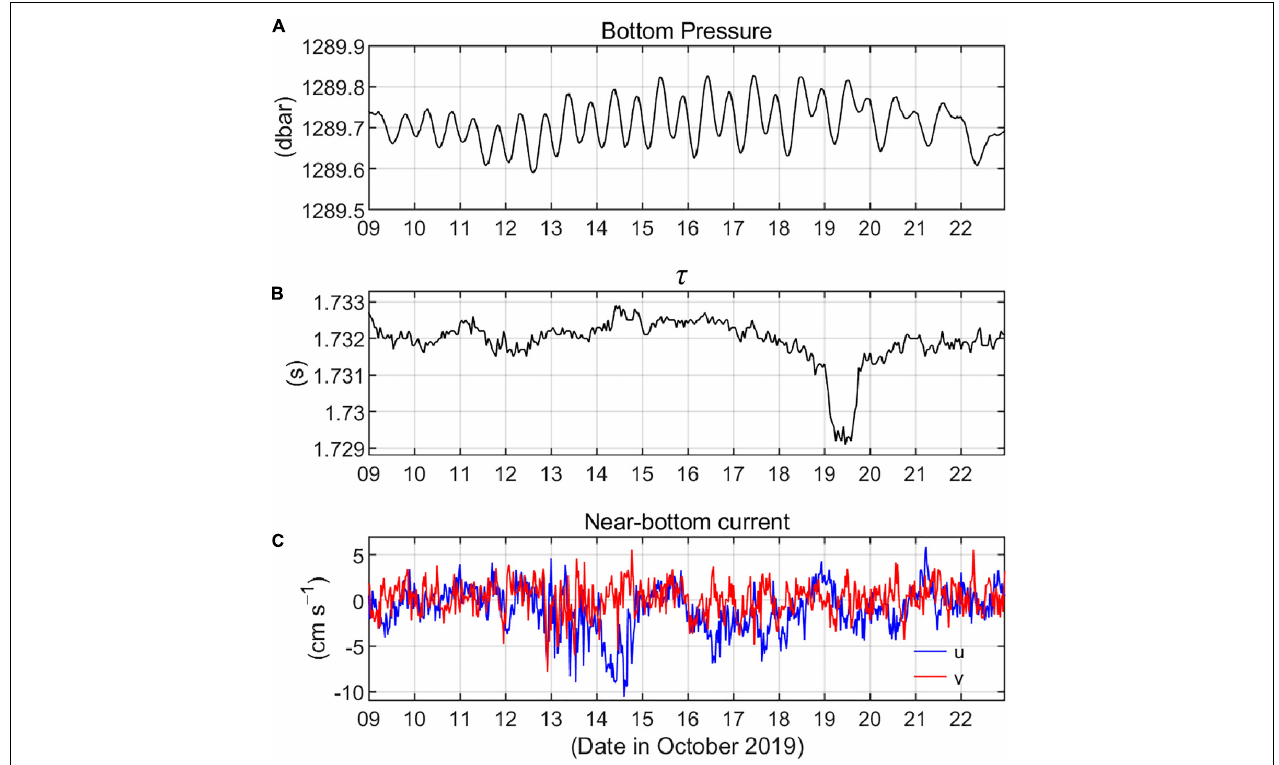
FIGURE 4 | Example of time series acquired from PDS at site AES4. (A) Bottom pressure, (B) τ , and (C) zonal and meridional velocities for the 14-day period of October 9–22,